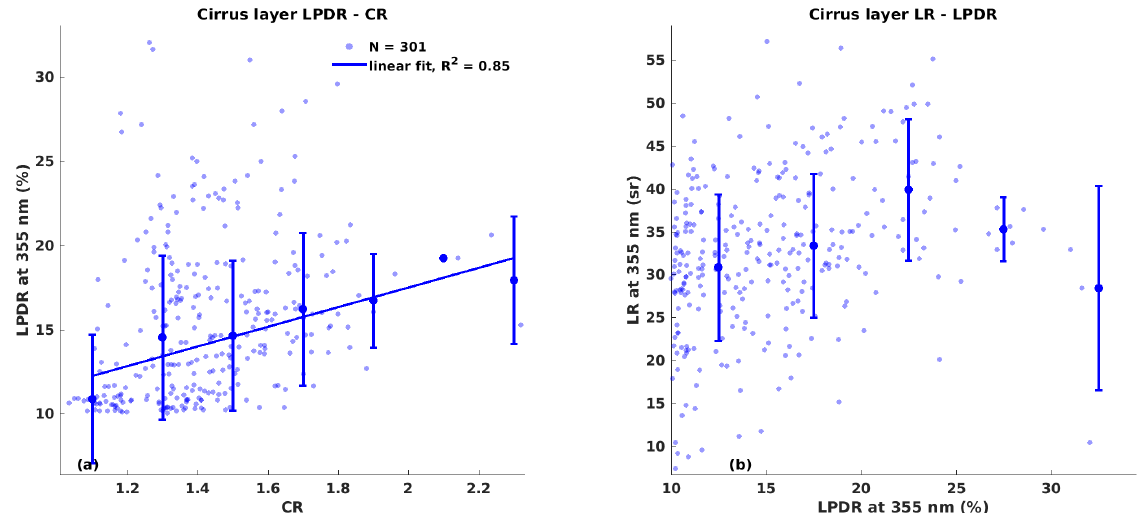
Figure 7. LPDR versus CR ( a ) and LR versus LPDR ( b ). The median ± standard deviation of LPDR (LR) in 0.2 CR (5% LPDR) classes is also given. The linear regression curve on the median values is overlaid only if the coefficient of determination ( R 2 ) exceeded